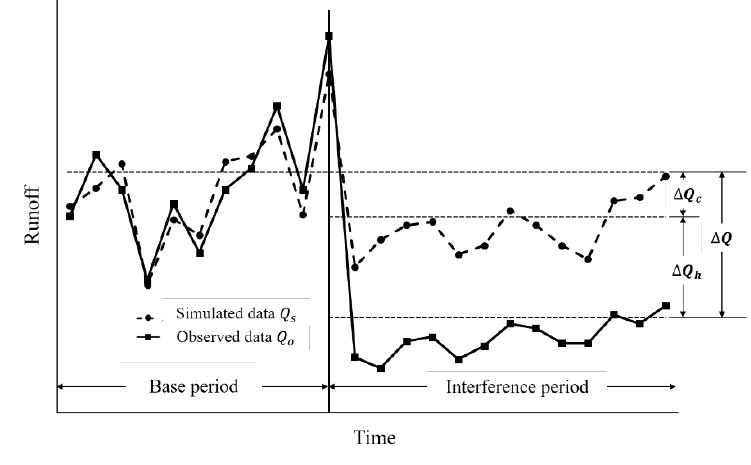
Figure 2. Runo ff impact assessment Figure 2. Runoff impact assessment model.